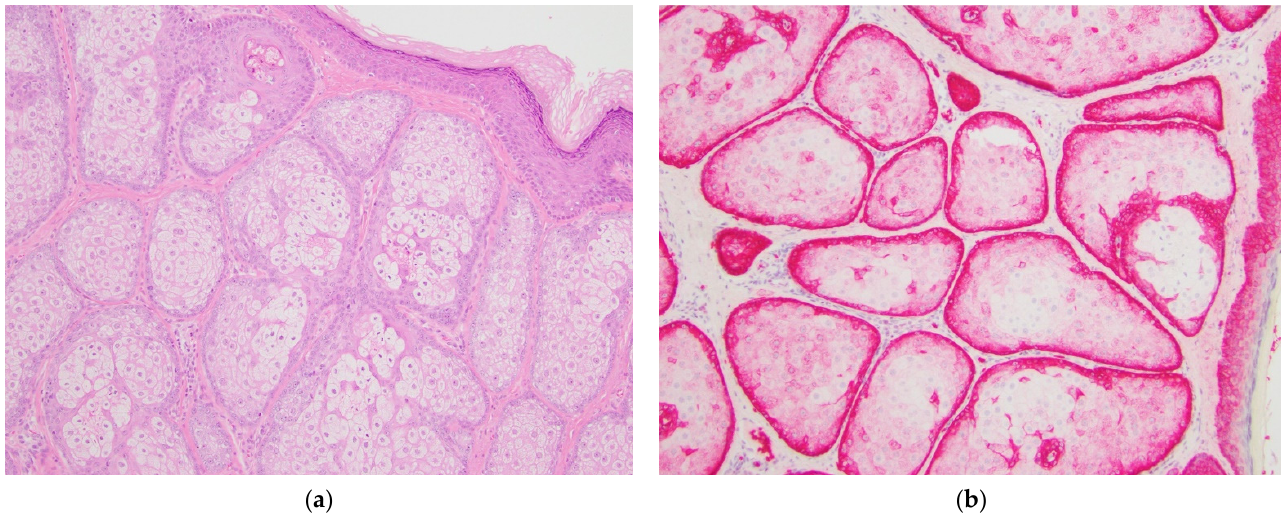
Figure 4. Sebaceous hyperplasia, sample case. ( a ) Hematoxylin and eosin-stained section showing a benign proliferation of sebaceous glands with a single layer of basaloid cells surrounding each lobule, original magnification 100×; ( b ) GLUT1 immunohistochemical stain of the same tumor showing primarily membranous staining only in the basaloid cells at the periphery of each lobule with staining becoming weaker to completely absent in the central mature sebocytes, original magnification 100×.